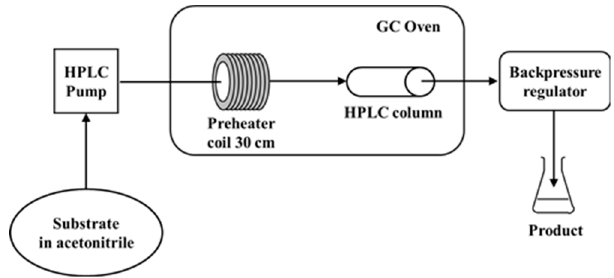
Figure 1. Schematic representation of the reactor used in the study.